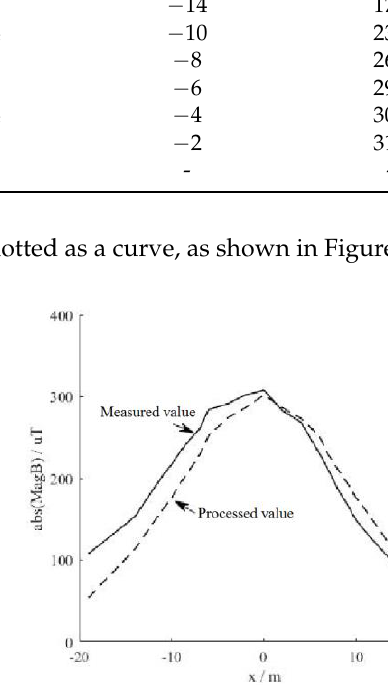
Figure 5. Measured value and processed value of pole I reactor.